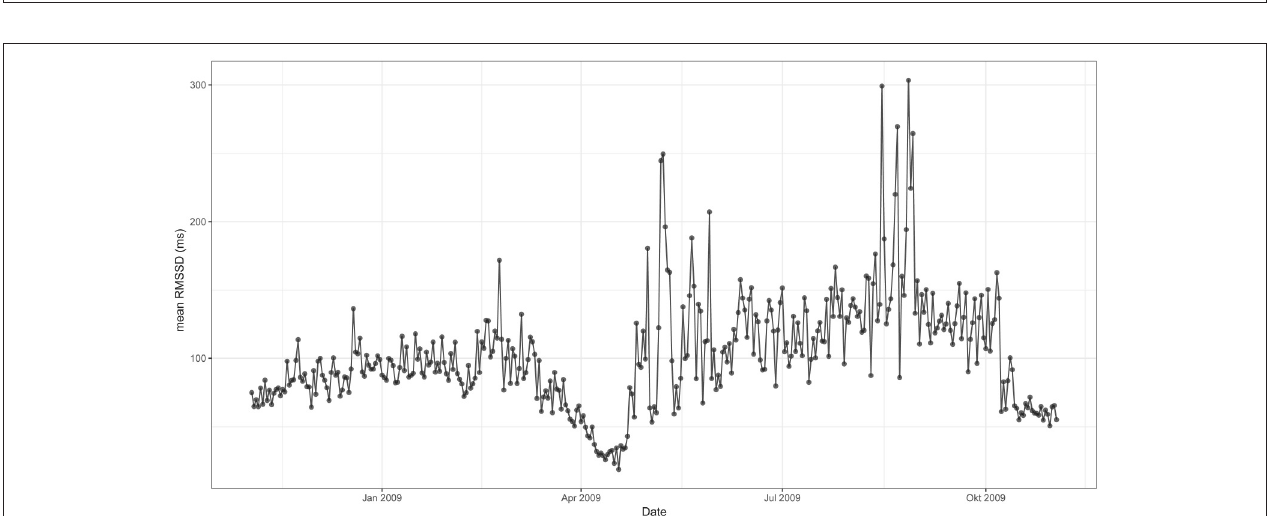
FIGURE 3 | Mean RMSSD from 12 p.m. to 6 p.m. throughout the 12 months study period [x-axis date (month), y-axis RMSSD (ms)]. RMSSD is lower during the winter than during the summer—it experiences a drop in